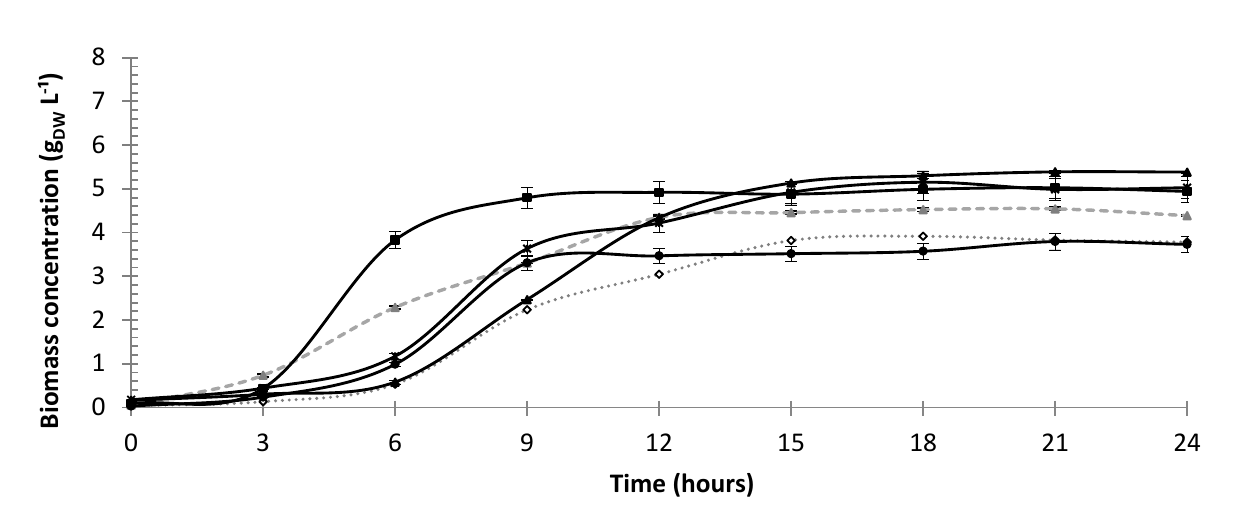
Figure 1. Growth of P. pentosaceus ATCC 43200 under different culture conditions. Central runs: 9 ( ■ ), 10 ( ● ) 11 ( ▲ ) and 12 ( ). Control runs without polydextrose: A (◊); B: ( ▲ ). For conditions of runs and controls see Table 1. Table 2. Kinetic parameters and yields of P. pentosaceus ATCC 43200 cultivations.